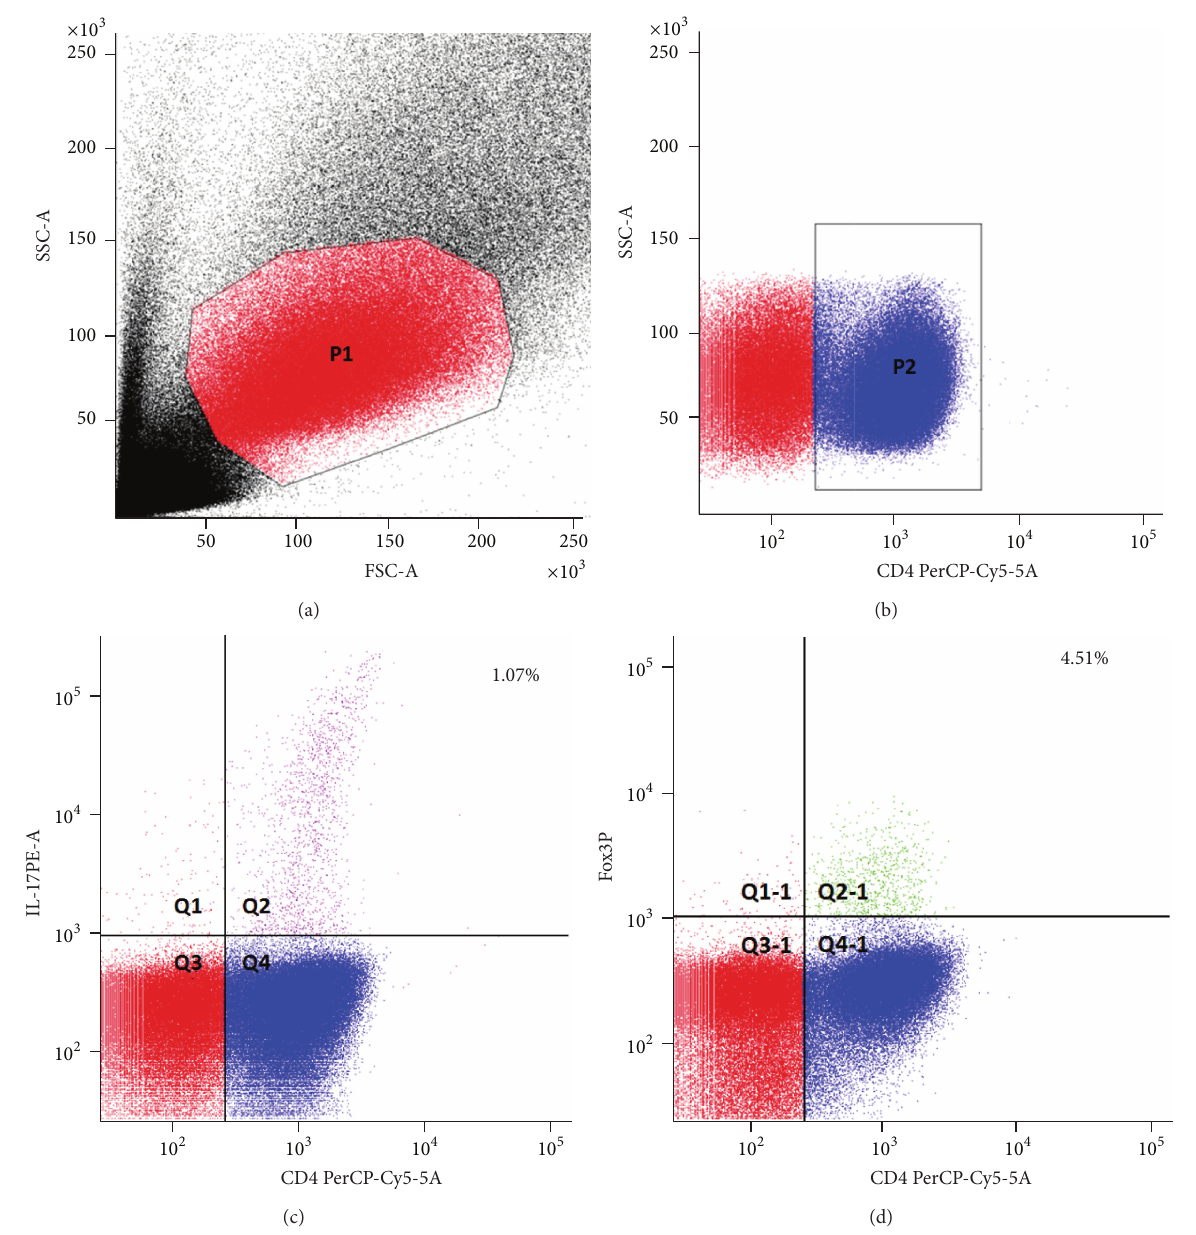
Figure 2: Flow cytometry analysis of Th17 and Treg cells. (a) The scatter plot shows forward and side scatter of the PBMC. (b) CD4 T cells are stained with CD4 PerCP-Cy5-5-A. (c) A percentage of Th17 cells are calculated by cells with double-positive IL17-A PE-A and CD4 PerCP- Cy5-5-A among CD4 PerCP-Cy5-5-A positive cells. (d) A percentage of Treg cells are calculated by double-positive Foxp3 APC-A and CD4 PerCP-Cy5-5-A among CD4 PerCP-Cy5-5-A